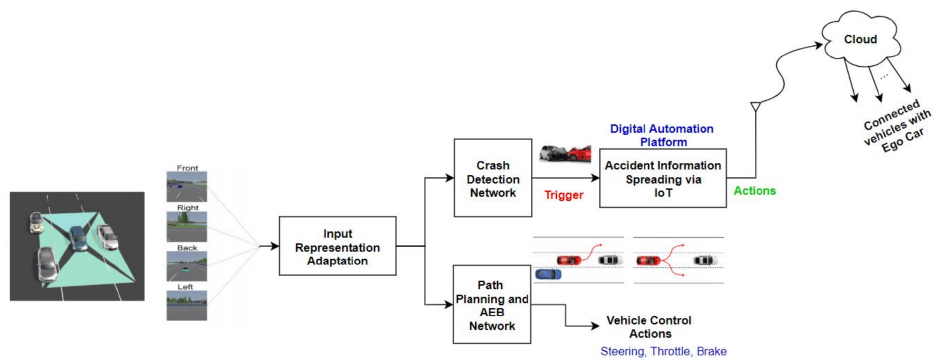
Figure 1. System architecture.